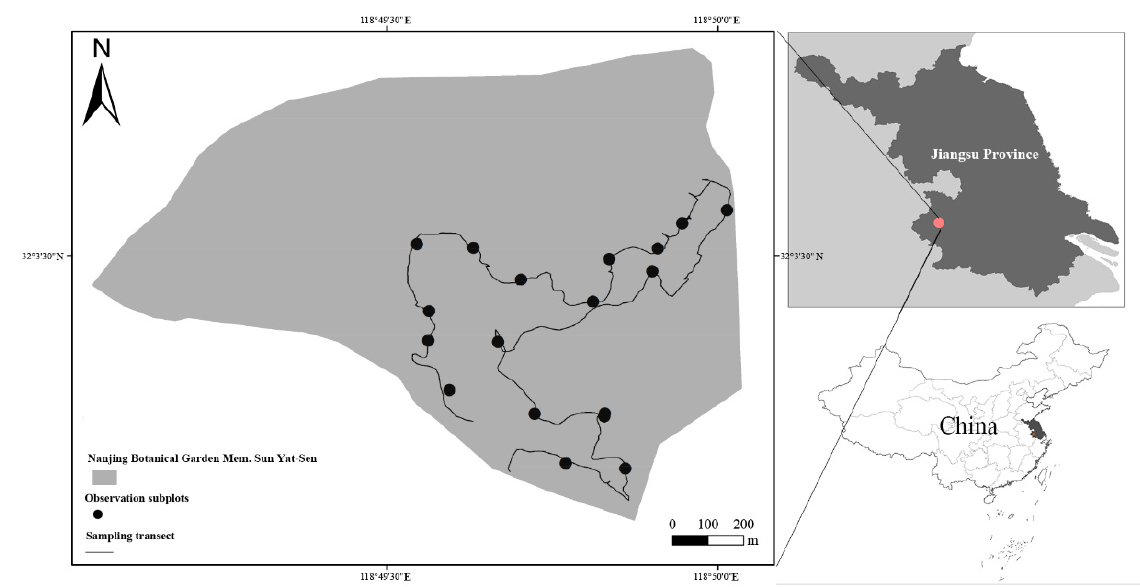
Figure 1. Map of the field site at Zhongshan Botanical Garden in Jiangsu province, China (each circle represents one 10 × 10 m 2 subplot monitored for fruit ripening phenology and subsequent bird for- aging).